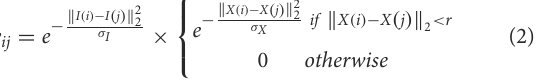
Algorithm 1 is present to determine the number of segments in an image.